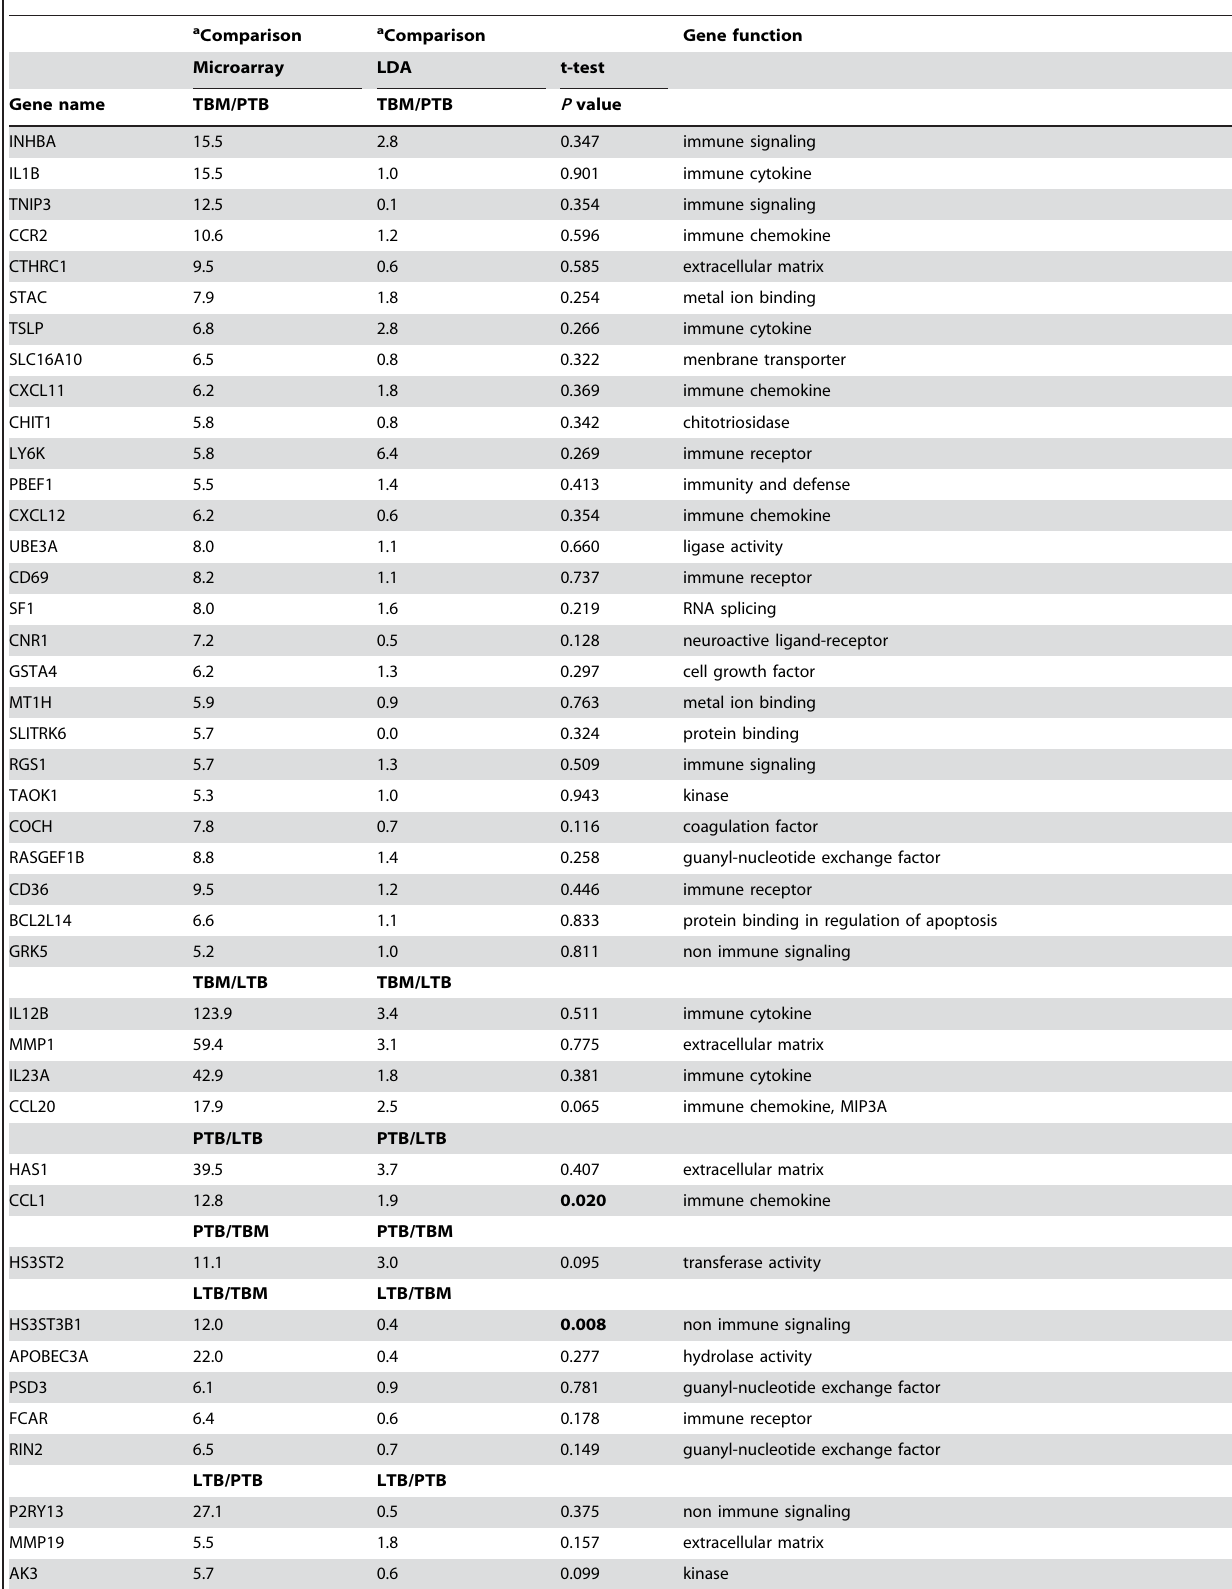
Table 4. Validation results for 46 genes with altered expression ratios among different clinical forms of